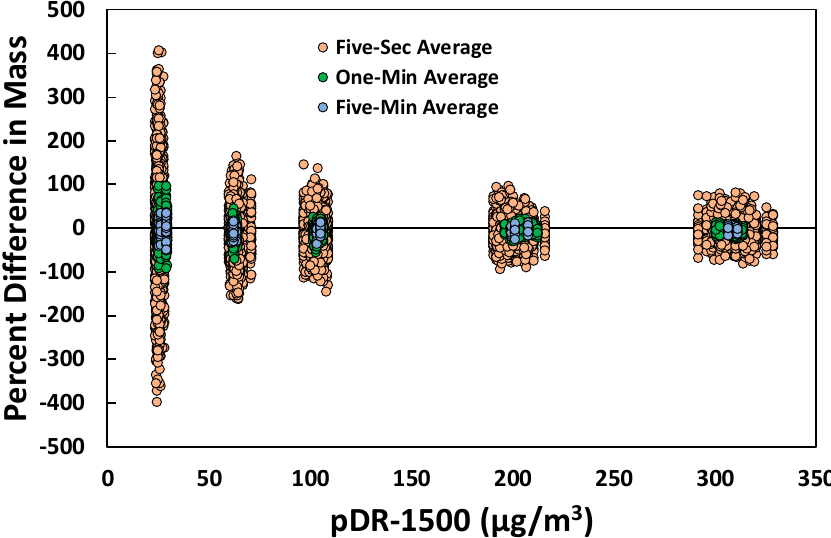
Figure 4. Percent difference between the calculated mass from the laboratory calibration of PM sensors and the pDR-1500 to compare different averaging times using Method 1, the Average Slope Method.